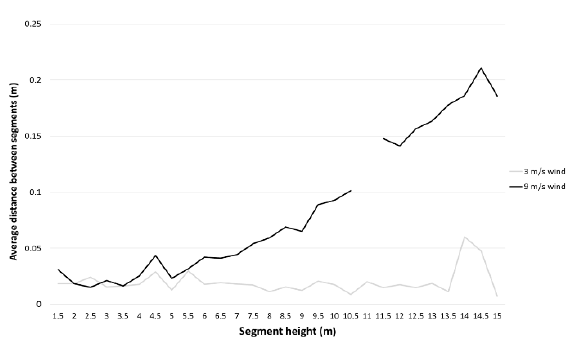
Figure 6. The average distance between the centre points of the fitted circles for three scans at different segment heights under 3 and 9 m/s wind